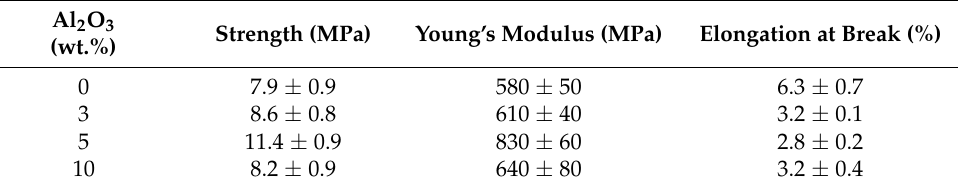
Figure 5. DMA-measured storage modulus and tan δ curves of the samples prepared by melt blending. An inset has been added to show in more detail the storage modulus values for the temperature range between 20 °C and 30 °C. Table 1. Elastic modulus, elongation at break, and tensile strength of the solvent cast samples as measured by tensile tests.